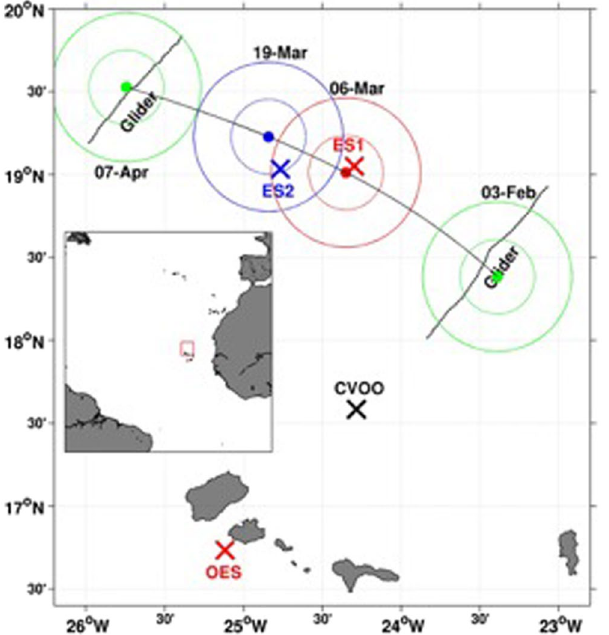
Figure 1. Locations of the relevant sampling sites. The Cape Verde Ocean Observatory (CVOO), outside eddy station (OES), eddy station 1 (ES1) and eddy station 2 (ES2) are marked with crosses, while the IFM12 and IFM13 glider surveys are indicated by dashed lines. The outer solid red and blue circles represent the position and area of the suboxic eddy during the ES1 and ES2 sampling events, respectively, while the outer solid green circles represent the location of the suboxic eddy during glider surveys (see description in Methods section). Note: the inner green, red and blue circles represent the area of the low DO core of the eddy. This map